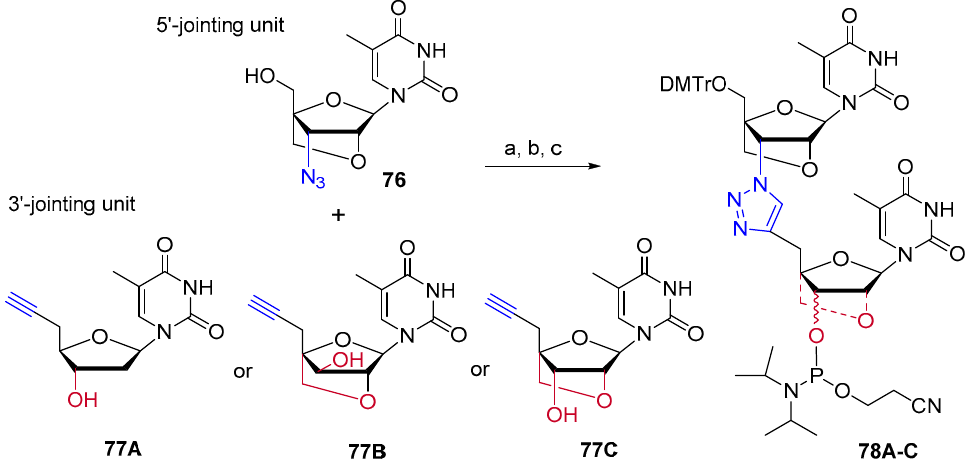
Scheme 19. Synthesis of triazole-linked LNA dinucleotides. Reaction conditions: ( a ) CuSO 4 · 5H 2 O, sodium ascorbate, THF:t-BuOH:H 2 O (1:1:1), r.t (yield: 91–92%); ( b ) DMTrCl, pyridine, r.t. (yield: 77–83%); ( c ) EtN(i-Pr) 2 , ClP(OCH 2 CH 2 CN)N(i-Pr) 2 , CH 2 Cl 2 , r.t.